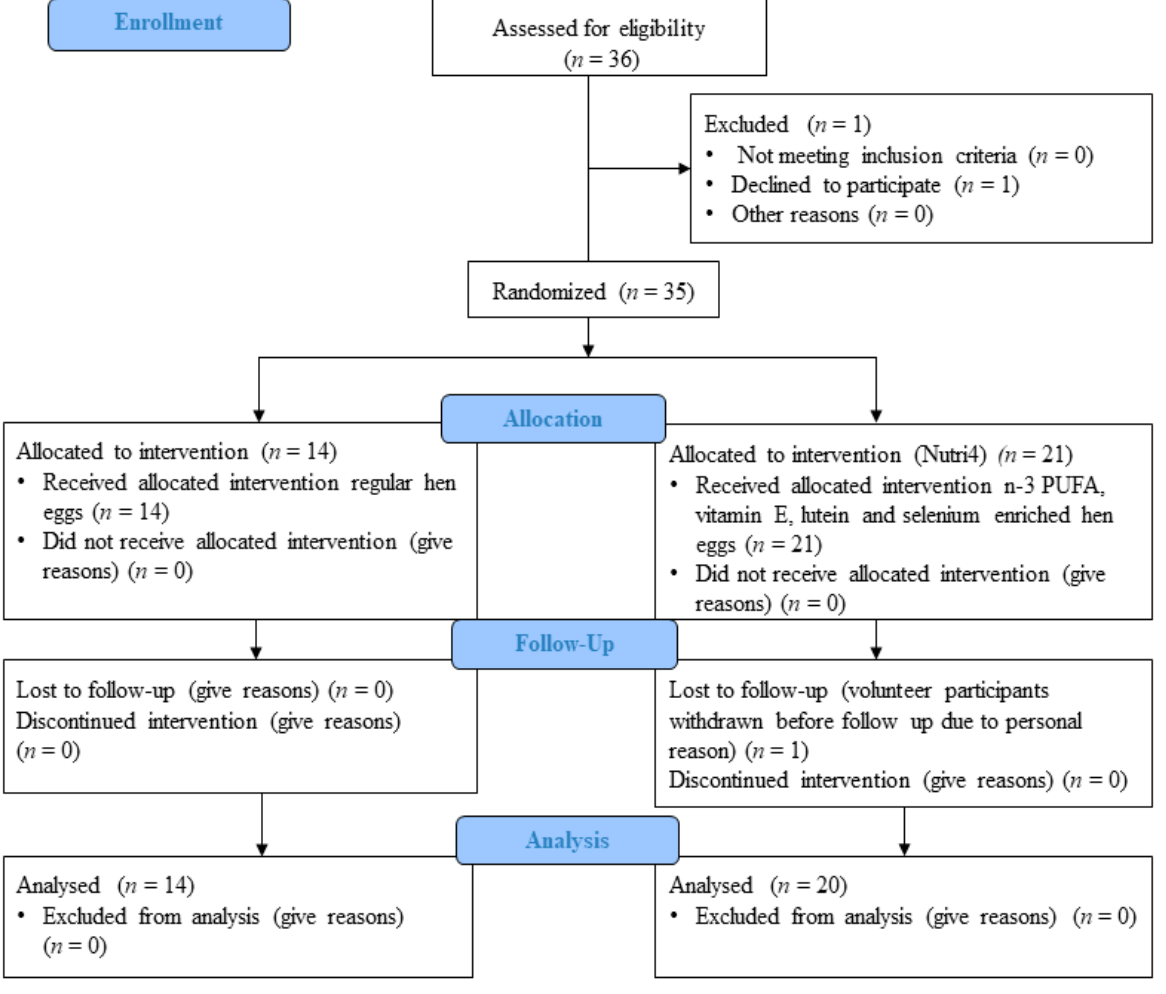
Figure 1. Consort study protocol.